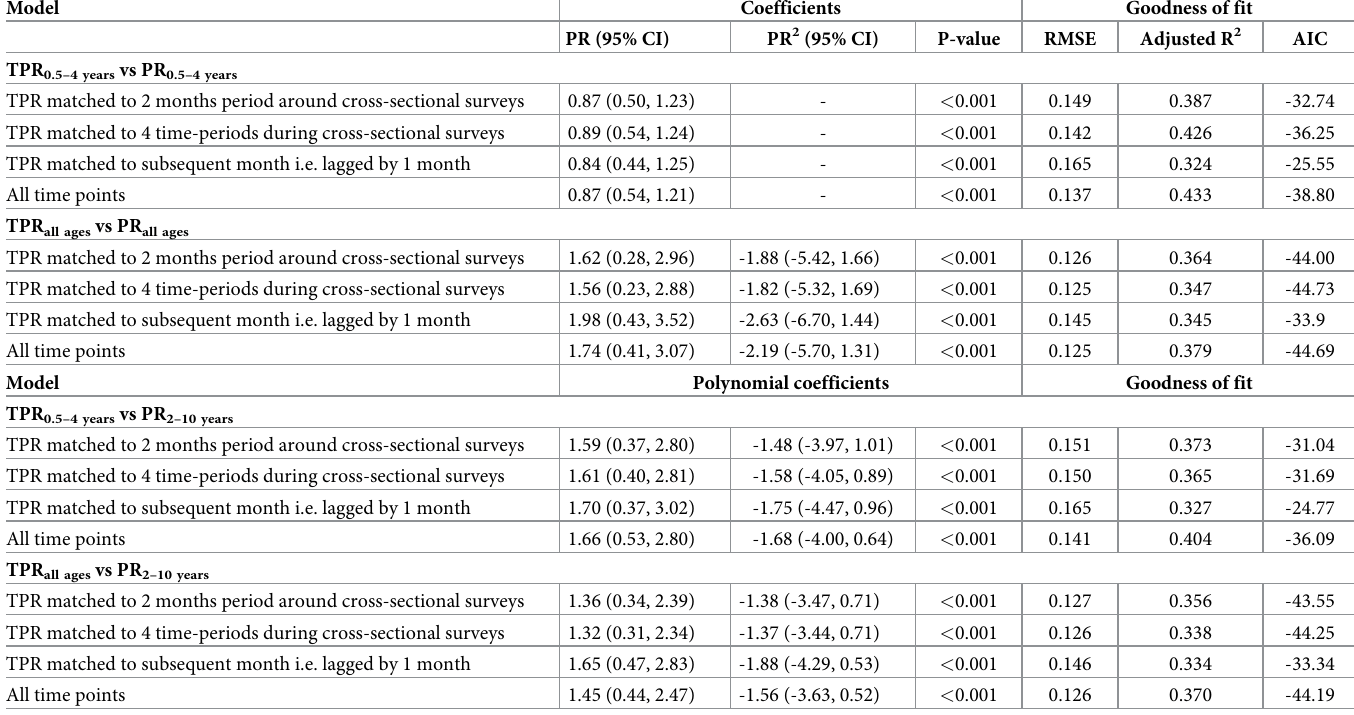
Table 3. Sensitivity analysis exploring the functional form of the relationship between health facility Test-Positivity Rate (TPR) and community parasite prevalence (PR) stratified by age-specific comparisons and temporal match.